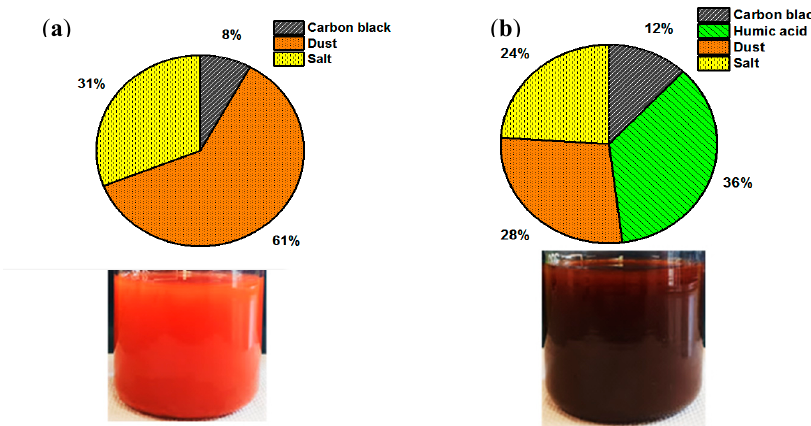
Figure 3. Volume fractions and their color of artificial soiling mixtures including carbon black, humic acid, dusts, and salts used to mimic the soiling of roofing materials, ( a ) marine, and ( b ) urban polluted environments.